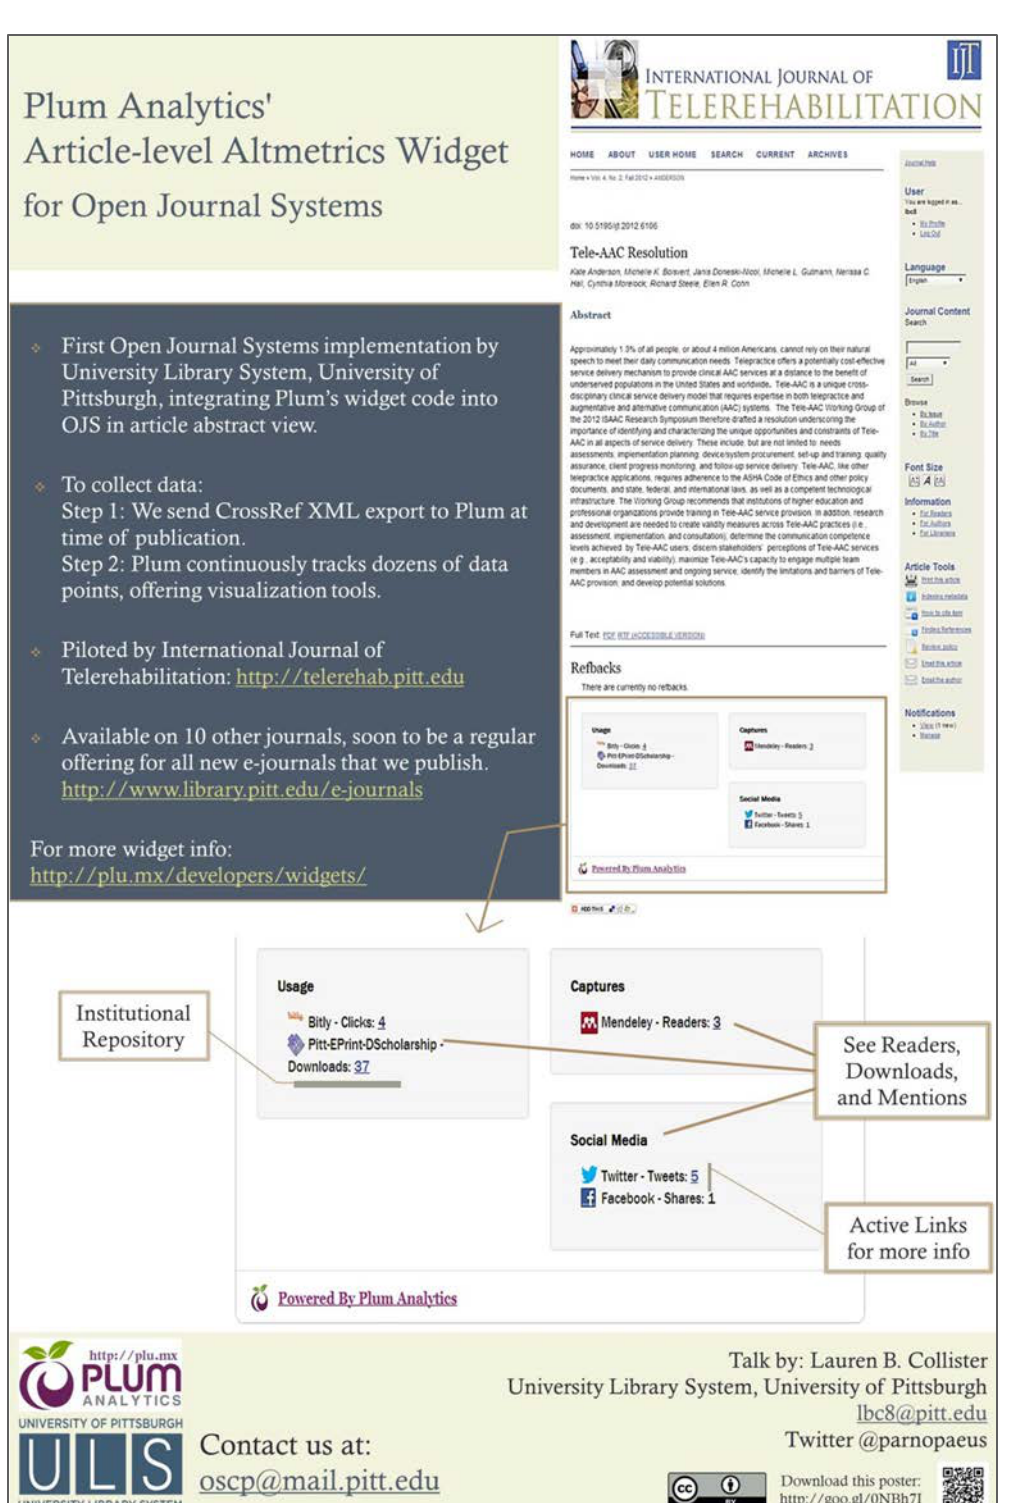
Plum Analytics’ Article-Level Altmetrics Widget for Open Journal Systems. Poster prepared by Lauren B. Collister, University Library System, University of Pittsburgh, for SPARC Open Access Meeting, 3 March